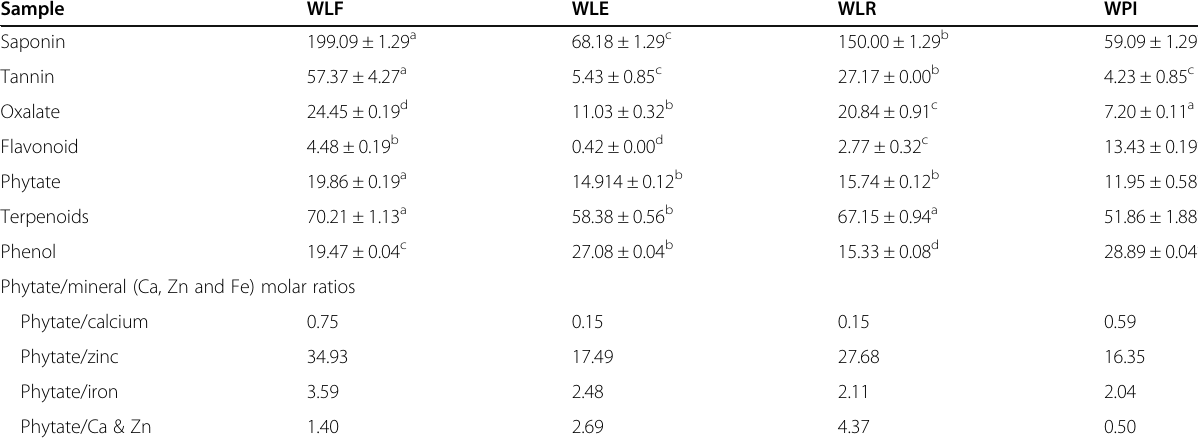
Table 4 Phytochemical compositions (mg ∙ g − 1 ) of African wild lettuce leaf samples Sample